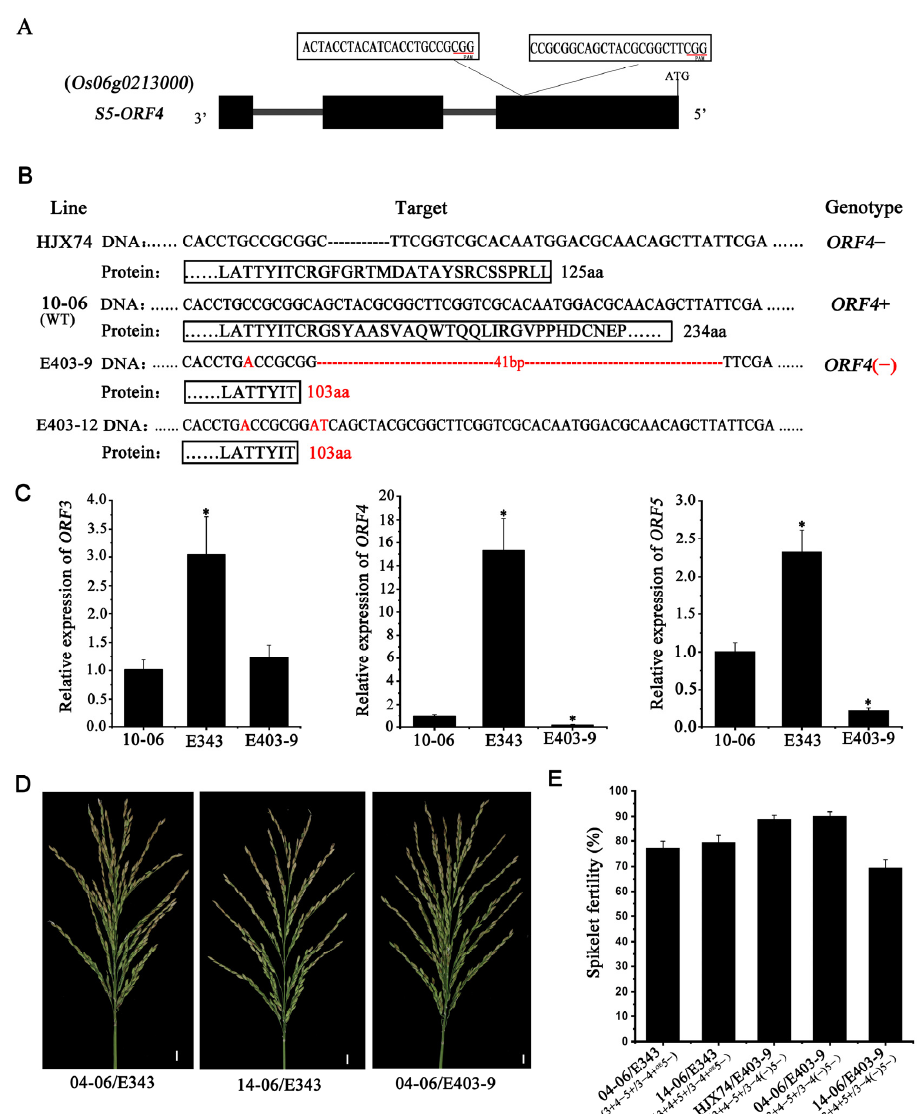
Figure 3. Knockout of ORF4 in SSSL S5 -10 improved the hybrid fertility ( A ) The sites of target sequences in ORF4 . The black boxes represent the exons. Two target sites are located on the first exon of the ORF4 gene. The target site is located in the box. The PAM sequence is underlined and shown in red. ( B ) Identification of mutations in ORF4 by sequencing of the target site in T 2 generation. The positions highlighted in red show the targeted mutations and deletions indicated by the red dash “ − ”. ORF4 ( − ) indicated the ORF4 gene loss of function. ( C ) qRT-PCR of ORF3 , ORF4 , and ORF5 expression levels of RNA isolated from young panicles in different lines. 10-06, wild-type. E343, ORF4 + overexpression plant in the 10-06 background. E403-9, ORF4 + edited mutant line in the 10-06 background. Profilin was the reference gene. Results were presented relative to the expression level of three ORF s in 10-06. * Significantly different at 0.05 probability level. ( D ) The panicles in F 1 hybrids from three crosses. Scale bar in panicles, 1 cm. ( E ) Spikelet fertility of hybrids F 1 from the crosses of indica -SSSLs with E343 or E403-9. The genotypes of the parents in the crosses were in parentheses, ORF3 , ORF4, and ORF5 were abbreviated as “3”, “4”, and “5”. Error bars represent SD, n = 10.